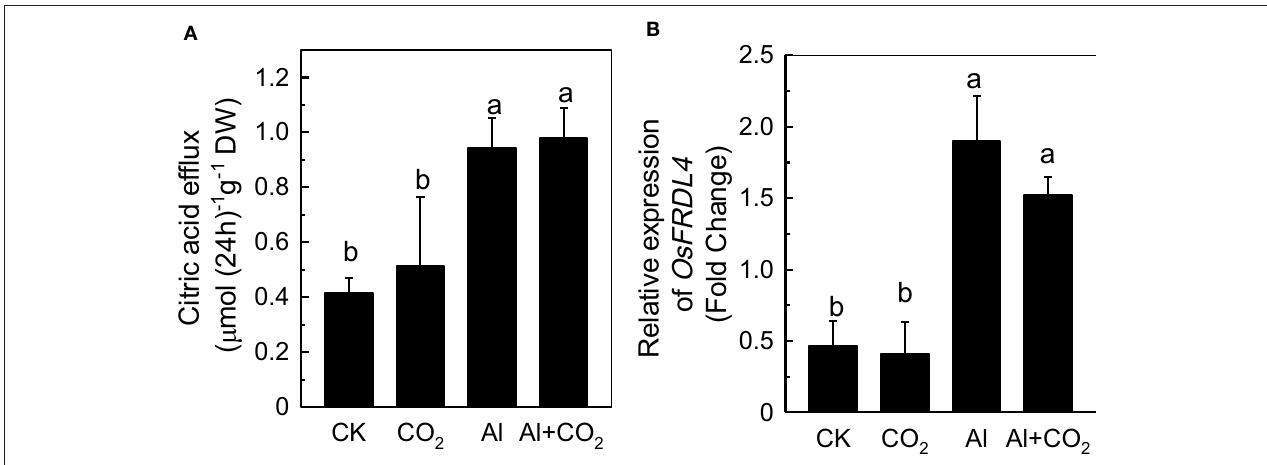
FIGURE 3 | Effects of elevated CO 2 on citric acid efflux (A) and the expression of OsFRDL4 (B) in Kas roots. Three-day-old rice seedlings were treated with 0.5 mM CaCl 2 solution with or without 50 µ M Al under ambient (400 µ L · L − 1 ; CK) or elevated (600 µ L · L − 1 ; CO 2 ) CO 2 for 24 h (pH 4.5). Root exudates were collected (A) and the root apex was detached for RNA extraction (B) . Expression levels of plants grown in ambient CO 2 without Al treatment were assigned as expression level of 1. Data are means ± SD ( n = 4). Columns with different letters are significantly different at P < 0.05.